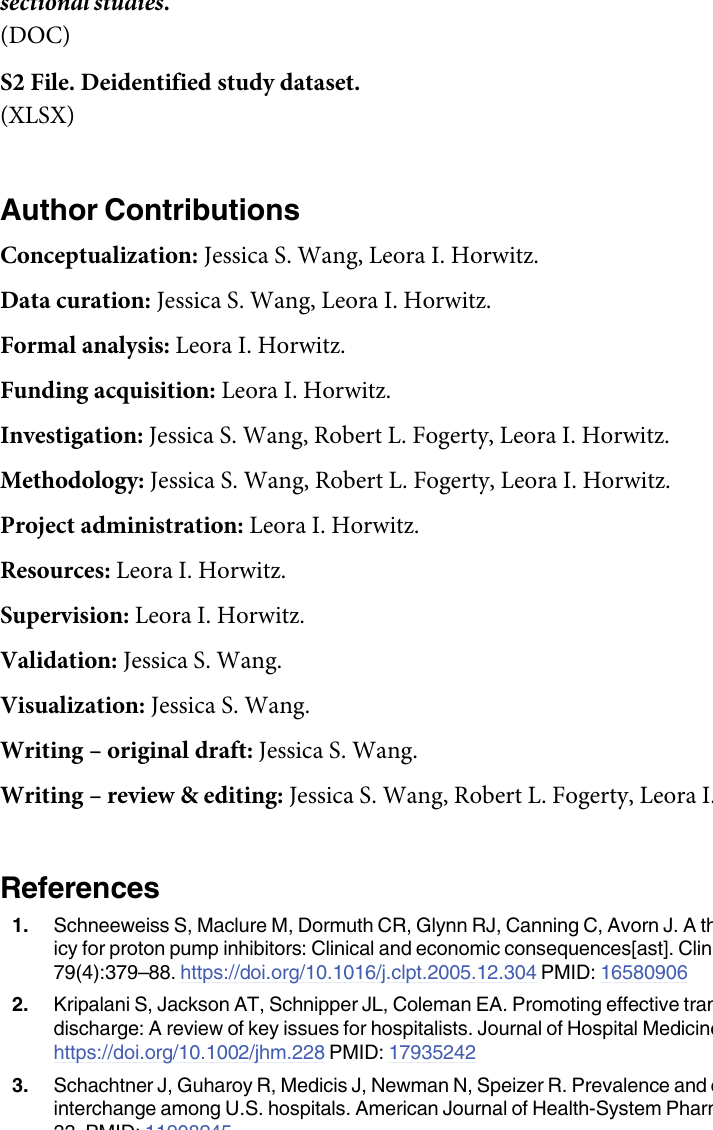
S1 Table. Formulary conversions for drug classes of